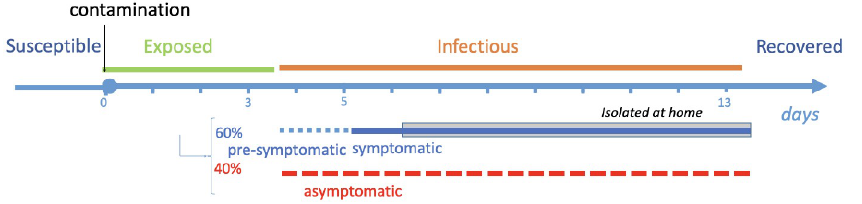
Fig 2. The infection model for SARS-CoV-2. The incubation (Exposed, green) lasts on average 3.7 days [11–13] and is followed by an infectious period (Infectious, orange) of 9.5 days on average, consisting of a presymptomatic period of average 1.5 days [11] followed by a symptomatic period of average 8 days [14]. We assume that symptomatic individuals self-isolate after one day of symptoms, while asymptomatic individuals (40% of the infected [15]) do not